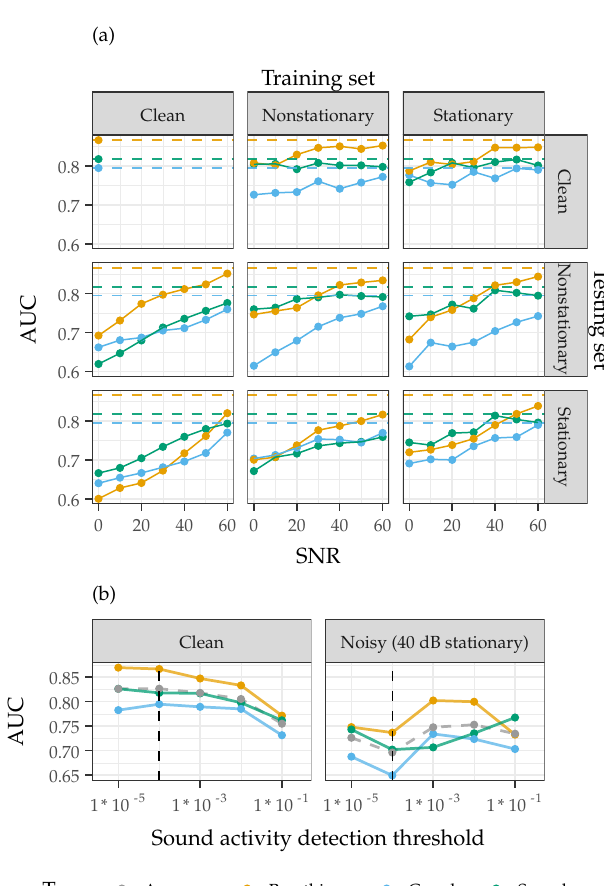
Figure 8. ( a ) System performance when injecting stationary and nonstationary noise of varying SNR levels into the train-test data for breathing, cough, and speech recordings. ( b ) The measured AUC-ROC at various SAD thresholds for the baseline classification system using recordings that are clean and with added stationary noise at a signal-to-noise (SNR) level of 40 dB. The chosen sound activity detection threshold (indicated by the dashed line) optimized the average performance across breathing, cough, and speech sounds for clean